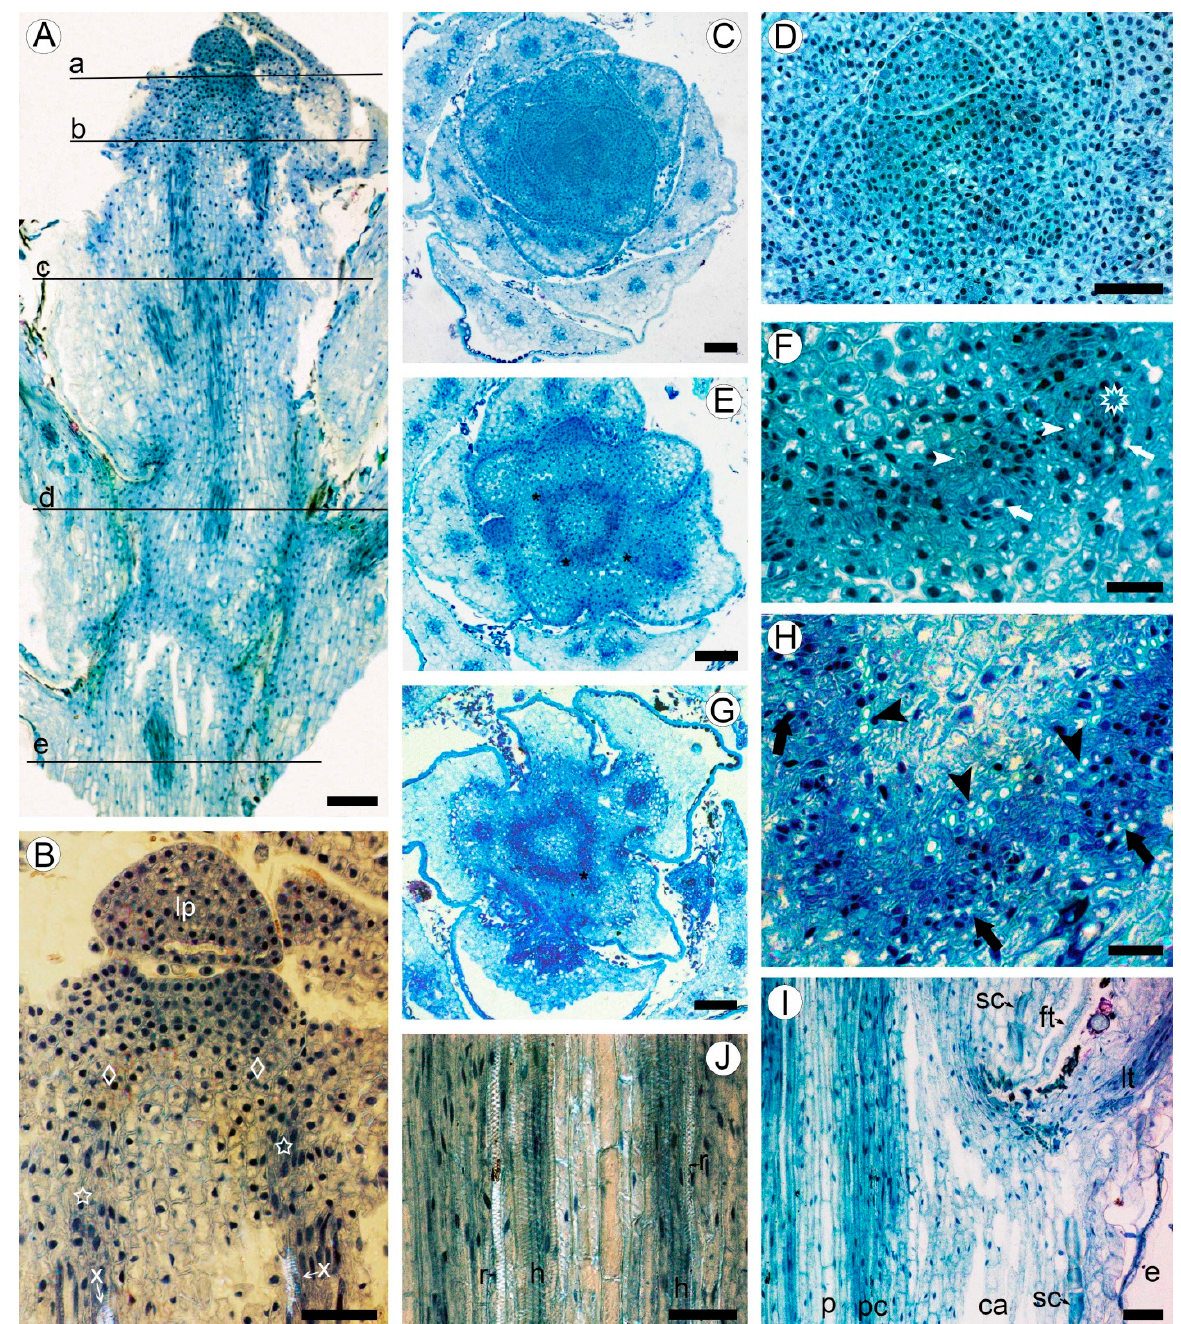
Figure 1. Apical meristem and primary tissues in young shoot of Aragoa corrugatifolia, light microscopy (LM). ( A ) Radial longitudinal section (RLS) of young shoot, approximate positions of the transverse sections (TS) shown on Figure 1C and 1D (a), 1E and 1F (b), 1G and 1H (c), 1I and 1J (d), and Figure 2A and 2B (e); ( B ) tip of young shoot observed in partially polarized light (RLS), shoot apical meristem (SAM) with leaf primordium (lp) and peripheral zone (diamonds), procambium cells (stars), protoxylem elements (x); ( C ) shoot tip at the SAM level (TS), 3/8 phyllotaxis, leaf primordia with solitary leaf traces, young leaves with three vascular bundles; ( D ) SAM with leaf primordia (TS); ( E ) shoot tip just below the SAM level (TS); procambium ring, leaf traces (asterisks); ( F ) portion of the procambium ring shown on Figure 1E (TS), leaf trace (asterisk), protoxylem (arrowheads), and protophloem (arrows) elements; ( G ) young shoot in the lower portion of first elongated internode (TS), procambium ring, offset of leaf trace (asterisk). ( H ) Portion of the procambium ring shown on Figure 1G (TS), radial seriations of procambial cells, elements of primary xylem (arrowheads) and primary phloem (arrows); ( I ) stem and leaf base at the level of fifth elongated internode (RLS), procambium ring (pc), pith (p), cortical aerenchyma (ca), sclereids at the leaf base (sc), epidermis, leaf trace (lt), filiform trichome (ft); ( J ) portion of the procambium ring shown in Figure 1I observed in partially polarized light (RLS), tracheary elements with helical (h) and reticulate (r) patterns of secondary cell wall. Scale bars: 100 µm for ( A , C , E , G ), 50 µm for ( B , D , I , J ), 20 µm for ( F , H ).